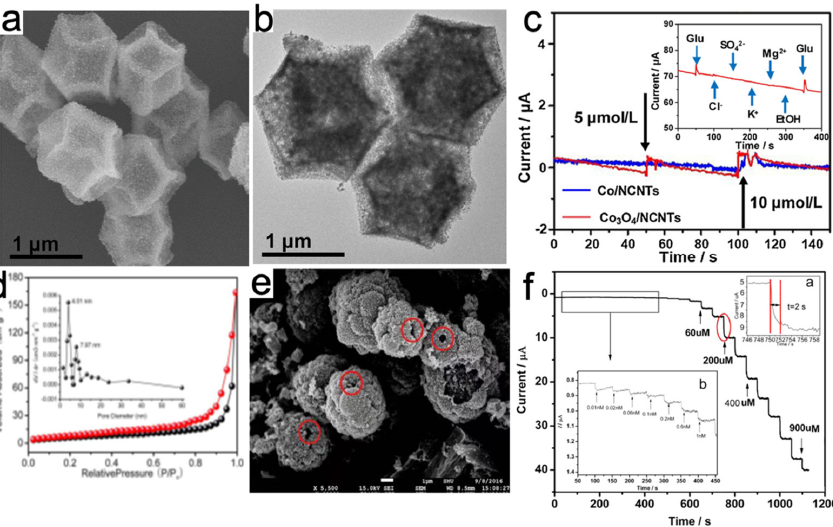
Figure 6. ( a ) Typical SEM images of Co 3 O 4 /NCNTs; ( b ) Typical TEM images of Co 3 O 4 /NCNTs; ( c ) Amperometric responses of Co/NCNTs and Co 3 O 4 /NCNTs with the addition of the same concentration H 2 O 2 [144]; Copyright 2020, Elsevier. ( d ) Nitrogen adsorption-desorption isotherm of meso-CuCo 2 O 4 . Insets, respectively, show the crystal structure and distribution of pore size of